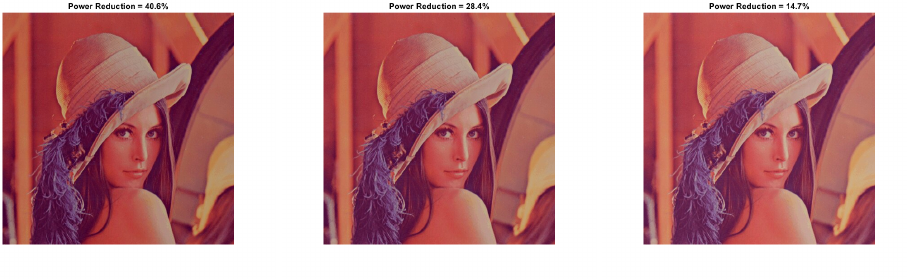
Figure 6. Resulted image I new using Y CBCS (without HE) for a = 0.7 and b = [10:10:30].